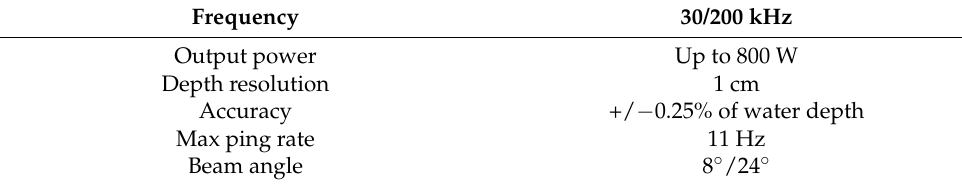
Table A4. Main features of Elac HydroStar 300.